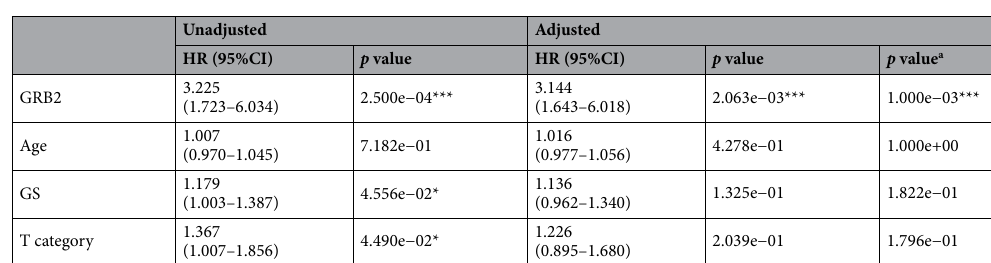
Table 3. Multivariate analysis of the effect of GRB2 expression on survival (based on data from the TCGA). GS: Gleason score: “*” and “***” indicate p value < 0.05 and < 0.001, respectively. a Adjusted p value (using a Bonferroni